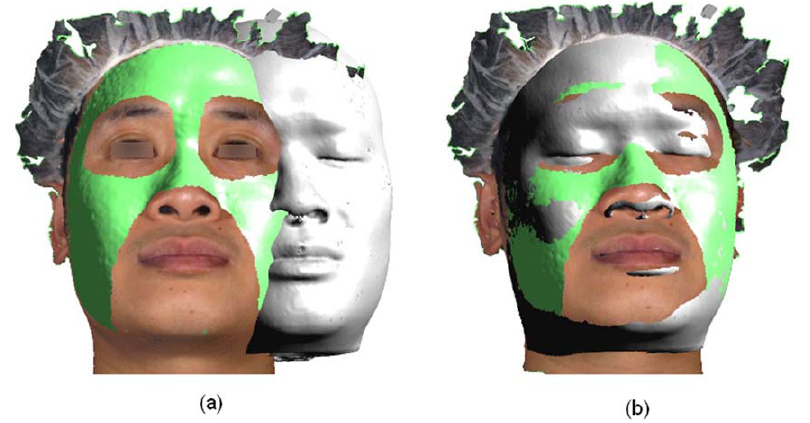
Figure 5. The matching of Cone-beam CT soft tissue and stereophotograhic images during registration. Initial manual aligning (a) is followed by automated registration (b).